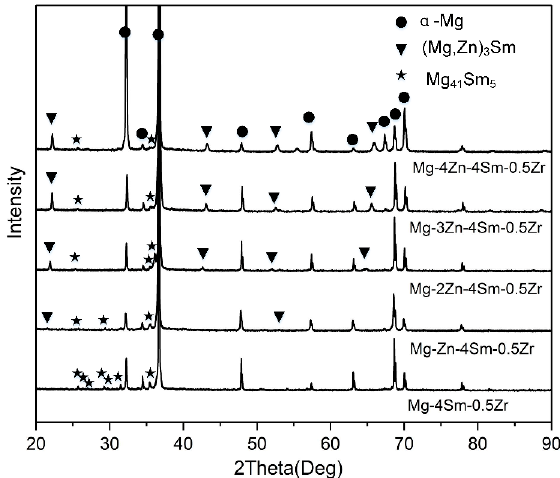
Figure 9. The XRD patterns of solution-treated Mg–4Sm– x Zn–0.5Zr ( x = 0, 1, 2, 3, 4) (wt %) alloys.